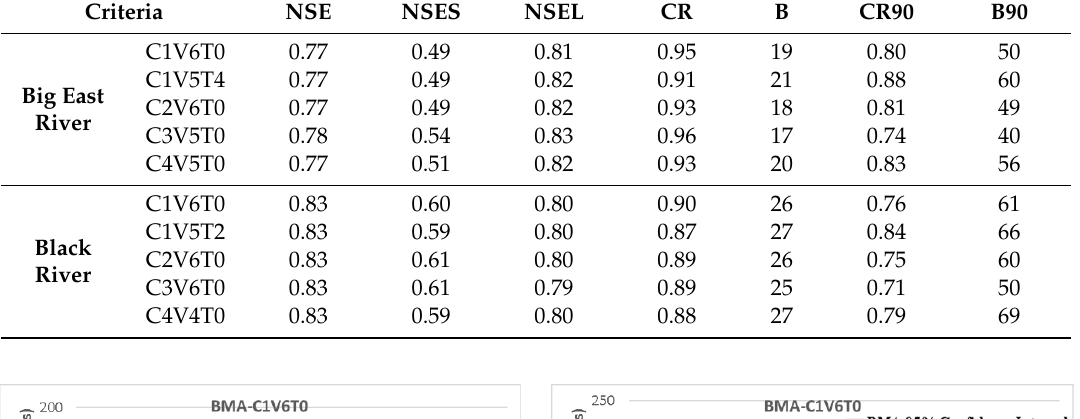
Table 6. The comparison of the performances of the best-selected BMA types for both the Big East River and Black River watersheds during the validation period.